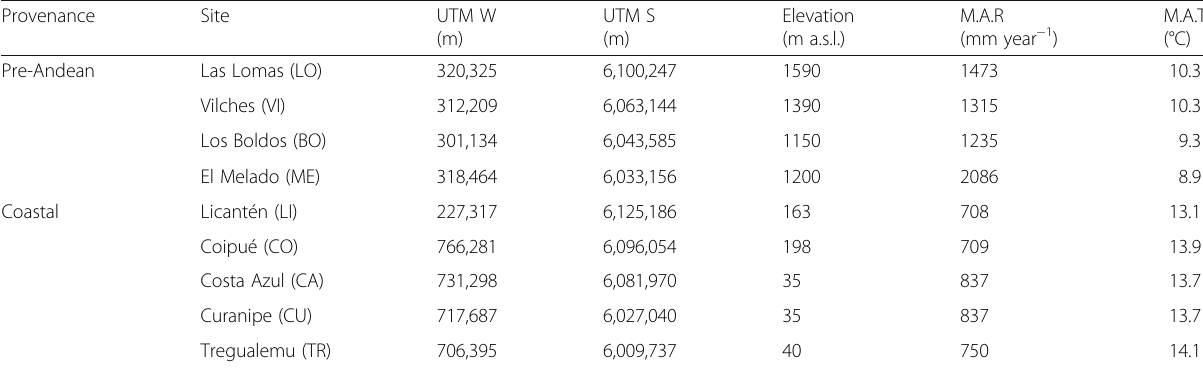
Table 1 Geographic and climatic data for provenances and sites sampled Provenance